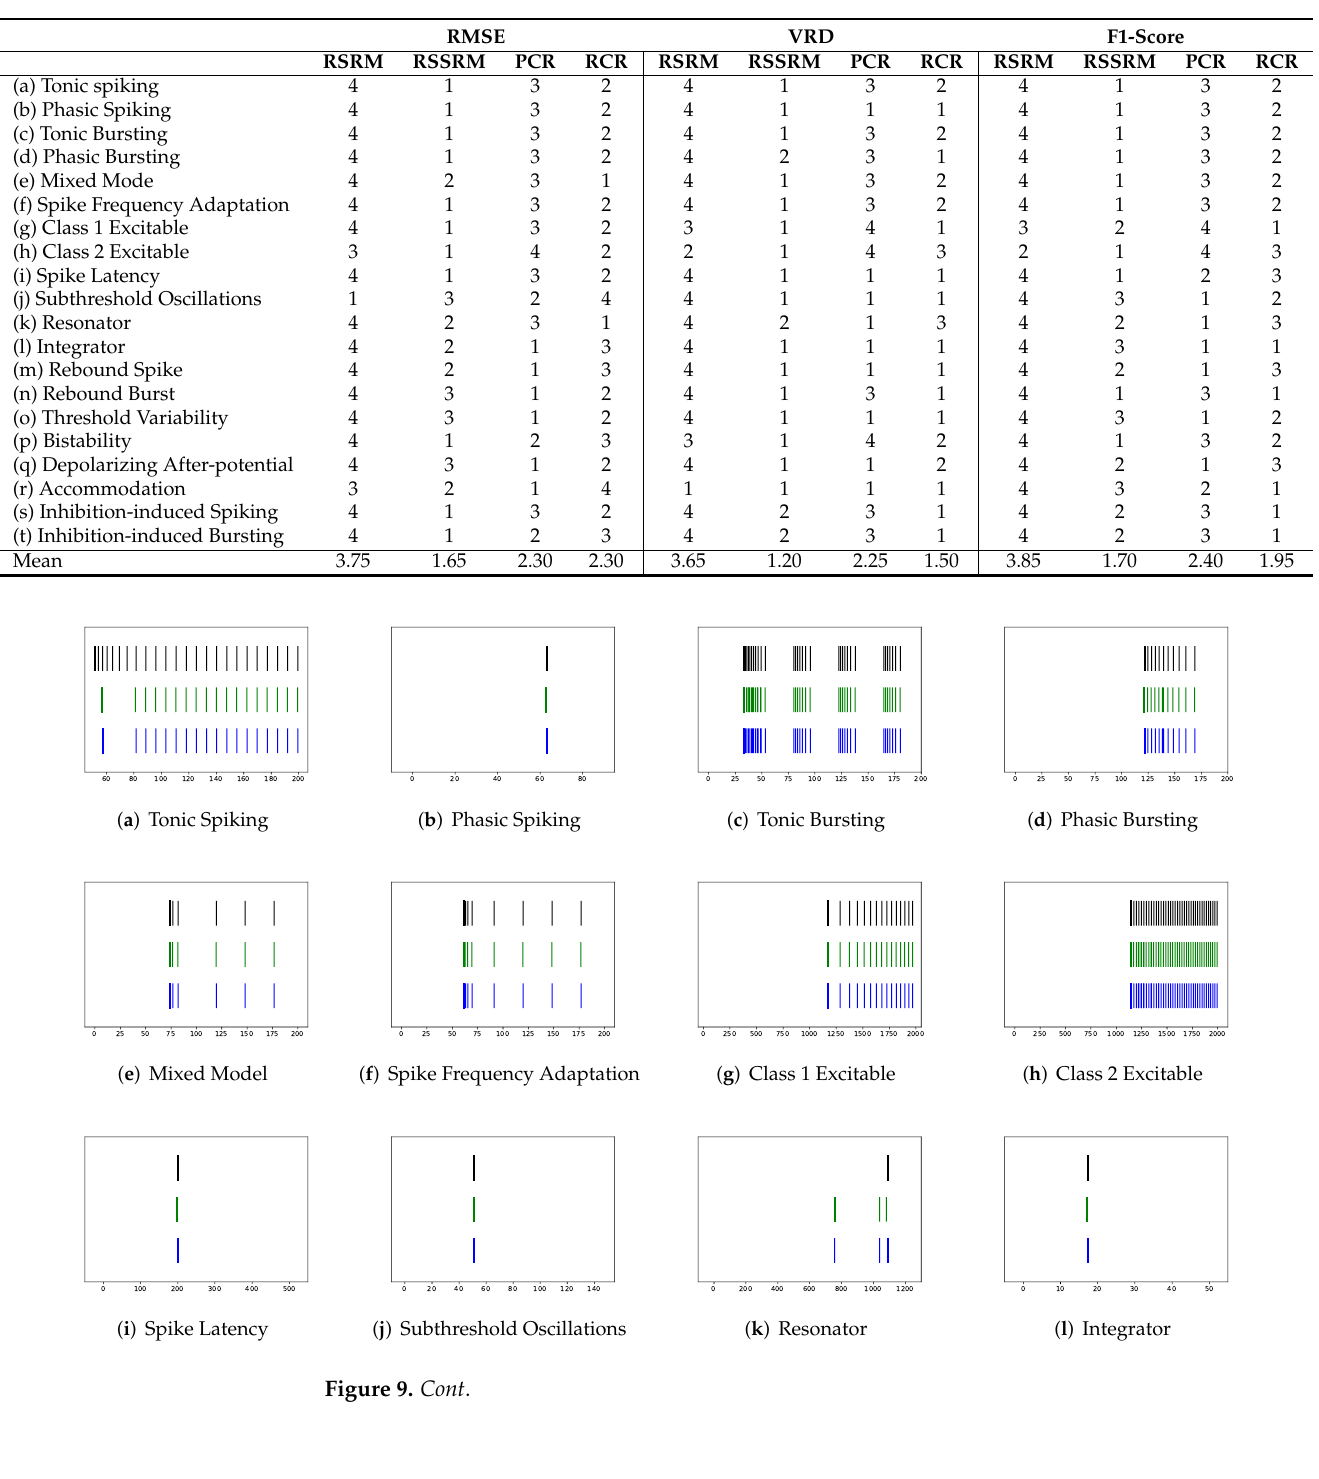
Table 6. Ranked Performance on twenty firing behaviors.